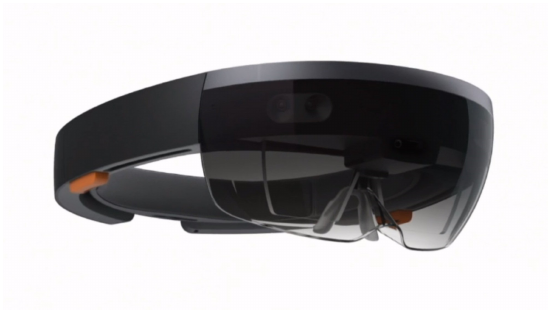
Figure 3. Standalone HoloLens AR device [31].